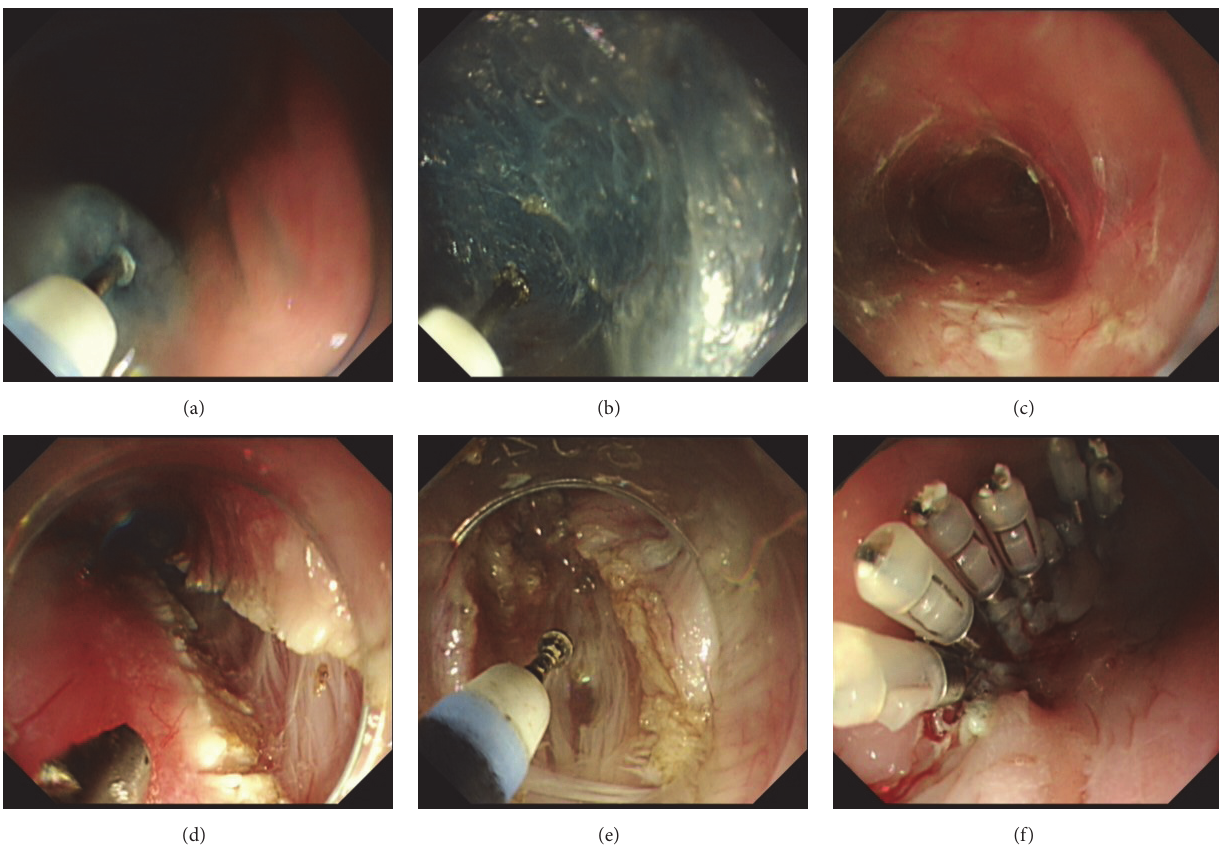
Figure 1: (a) Submucosal injection. (b) Creating submucosal tunnel. (c) Submucosal tunnel was dissected. (d) Circular muscle myotomy. (e) full-thickness muscle myotomy. (f) Closure of the mucosal entry site (with metallic clips).